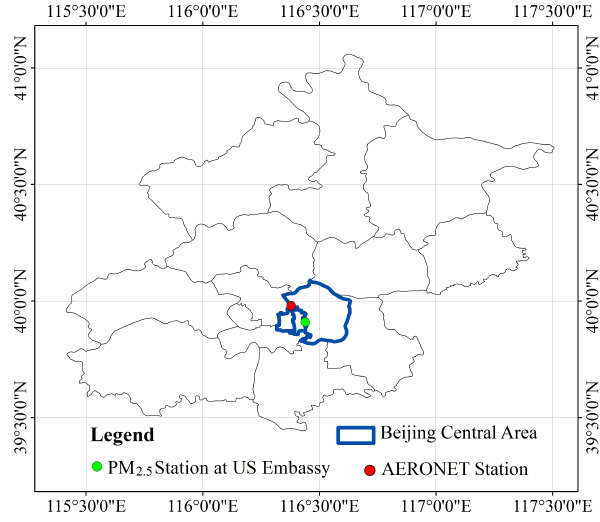
Figure 1. Map of Beijing with AERONET and PM 2 . 5 stations. The green point refers to the PM 2 . 5 station at the US Embassy, the red point is the AERONET station, and the blue line represents the Beijing central area, which includes the districts Chaoyang, Dongcheng, and